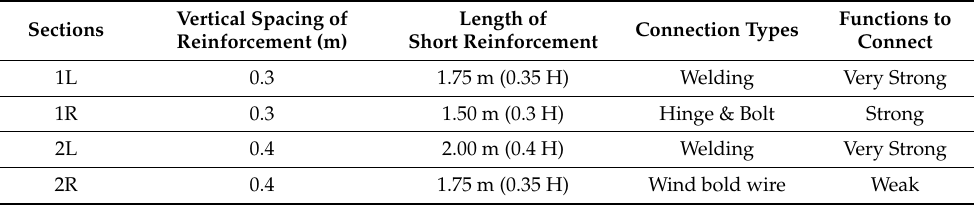
Figure 3. Cross sections of the full scale RSR. Table 1. Detailed specifications of four sections.